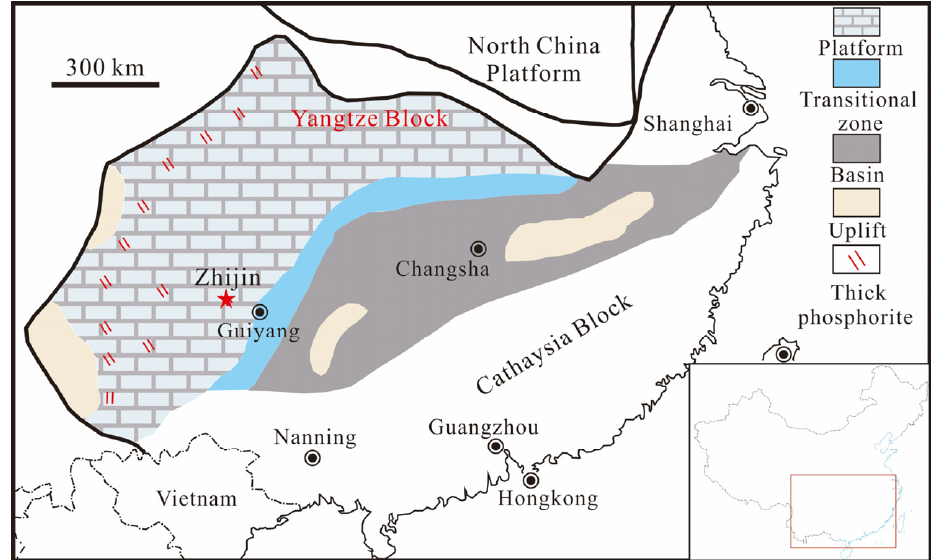
Figure 1. Petrographic paleogeography of South China during the early Cambrian Period, modified after [18]. The red pentagram represents the Zhijin Area.